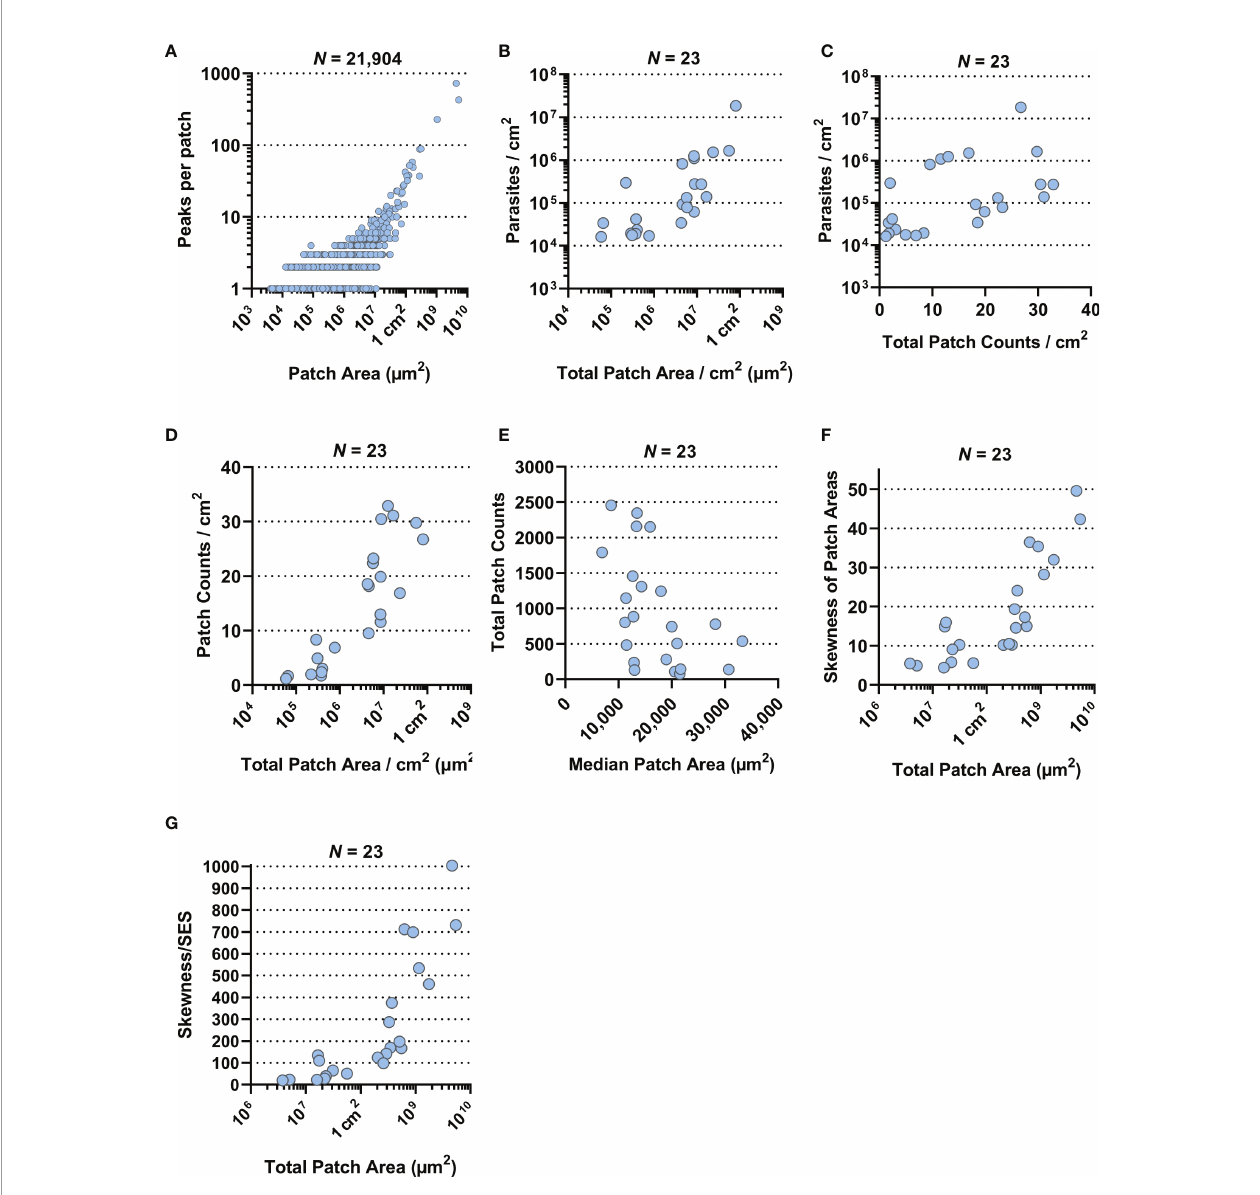
FIGURE 3 | Correlation plots. All data presented here were generated by the ImageJ-based analysis of stereomicroscopic images. (A) Correlation plot of 21,904 skin parasite patches by area (µm 2 ) from 23 RAG mice against the number of high-density peaks per individual patch (both on a log-scale; Spearman r : p < 0.0001, r = 0.3831, 95% CI = 0.3714 – 0.3947). (B) Correlation plot of total parasite patched skin by area (µm 2 ) normalized to 1 cm 2 of skin against parasite burden/cm 2 for each of the 23 RAG mice (both on a log-scale; Spearman r : p < 0.0001, r = 0.7589, 95% CI = 0.4948 – 0.8947). (C) Correlation plot of total skin parasite patch counts normalized to 1 cm 2 of skin against mean parasite burden per punch biopsy for each of the 23 RAG mice (on a log-scale; Spearman r : p = 0.0021, r = 0.5741, 95% CI = 0.1997 – 0.8022). (D) Correlation plot of total parasite patched skin by area (µm 2 ) normalized to 1 cm 2 of skin (on a log-scale) against total skin parasite patch counts normalized to 1 cm 2 of skin for each of the 23 RAG mice (Spearman r : p < 0.0001, r = 0.8656, 95% CI: 0.6984 – 0.9432). (E) Correlation plot of the median patch area (µm 2 ) against total skin parasite patch counts for each of the 23 RAG mice (Spearman r : p = 0.006, r = − 0.5148, 95% CI = − 0.7701 to − 0.1175). (F) Correlation plot of total parasite patched skin by area (µm 2 ; on a log-scale) against the skewness of parasite patch area data for each of the 23 RAG mice (Spearman r : p < 0.0001, r = 0.8686, 95% CI = 0.7044 – 0.9445). (G) Correlation plot of total parasite patched skin by area (µm 2 ; on a log-scale) against the test statistic that infers skewness to the population for each of the 23 RAG mice (Spearman r : p < 0.0001, r = 0.9279, 95% CI = 0.8311 –